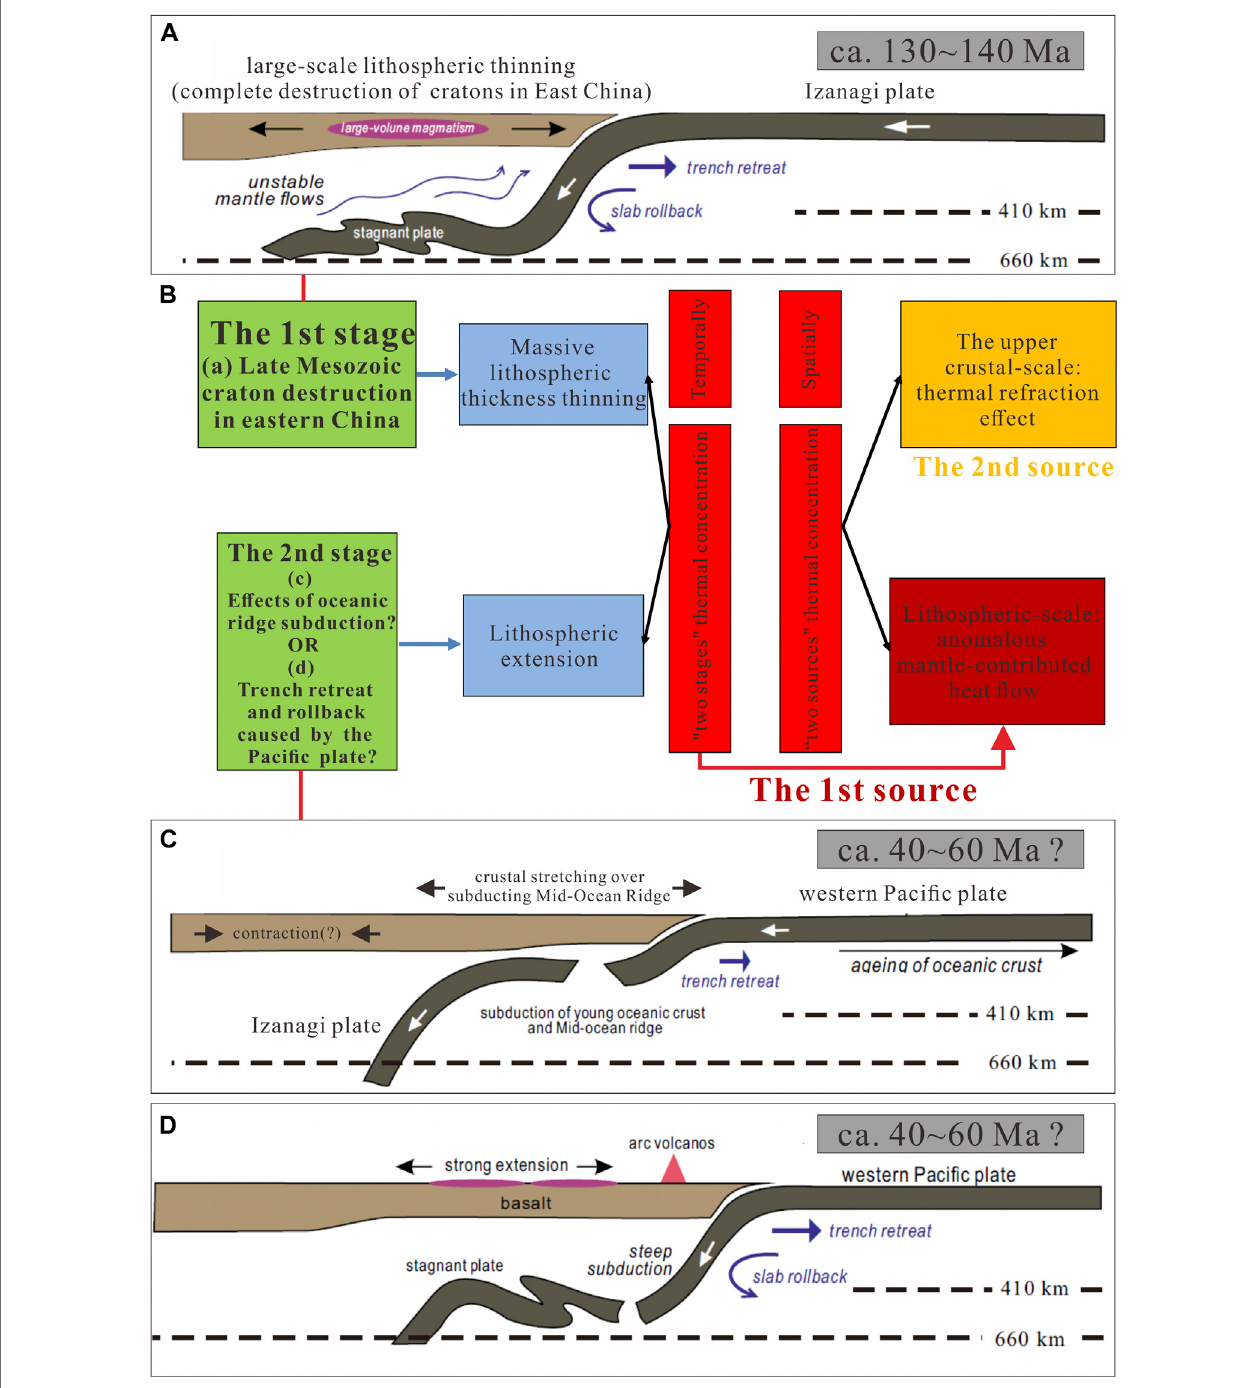
FIGURE10| Thekineticmechanismandmodelof “ twostages,twosources ” thermalconcentrationintheLowerYangtzeCraton( (A) , (C) ,and (D) arethepossible kineticbackgroundofthethermalconcentrationintheLowerYangtzeCraton( (C) and (D) arethearetwopossiblemechanismscausinglithosphericextension)(modi fi ed from Zhu et al. (2017)); (B) is the “ two stages, two sources ” thermal concentration model).